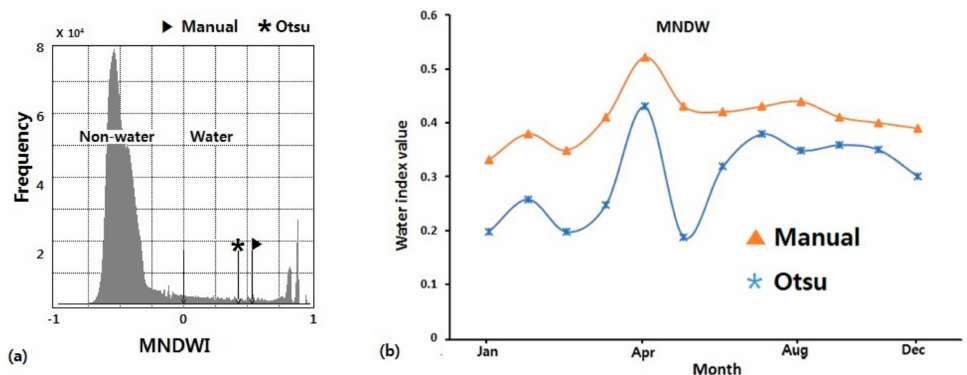
Figure 7. ( a ) Histogram of MNDWI image showing specific locations of water thresholds for L8 12-January 2015. ( b ) Comparison between MNDWI thresholds derived from the Otsu and Manual threshold selection methods. Landsat 8 image acquisition dates 12-January, 13-February, 17-March, 17-April, 20-May, 21-June, 7-July, 25-September, 27-October, 28-November and 30-December 2015. (Landsat 7 image acquisition date: 21-August-2011).